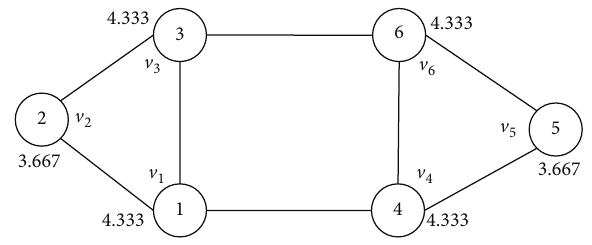
Figure 3: The toy sample